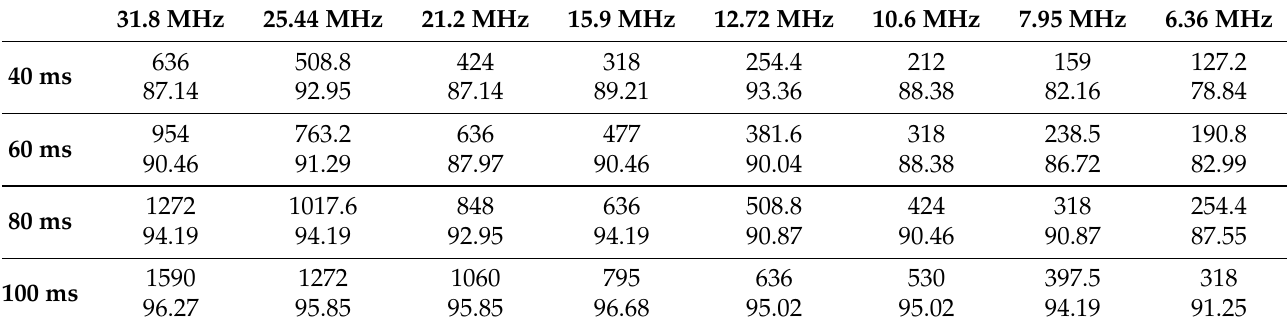
Table 3. Snapshot data size (1st value, in kB) and SRTK fix rate (2nd value, percentage) for different integration times and bandwidths at 15 km baseline